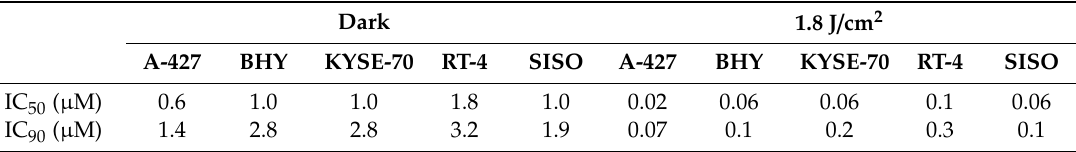
Table 1. Established IC 50 and IC 90 values from MTT cell viability assay 24 h after incubation in the dark and post illumination with a light dose of 1.8 J / cm 2 ,